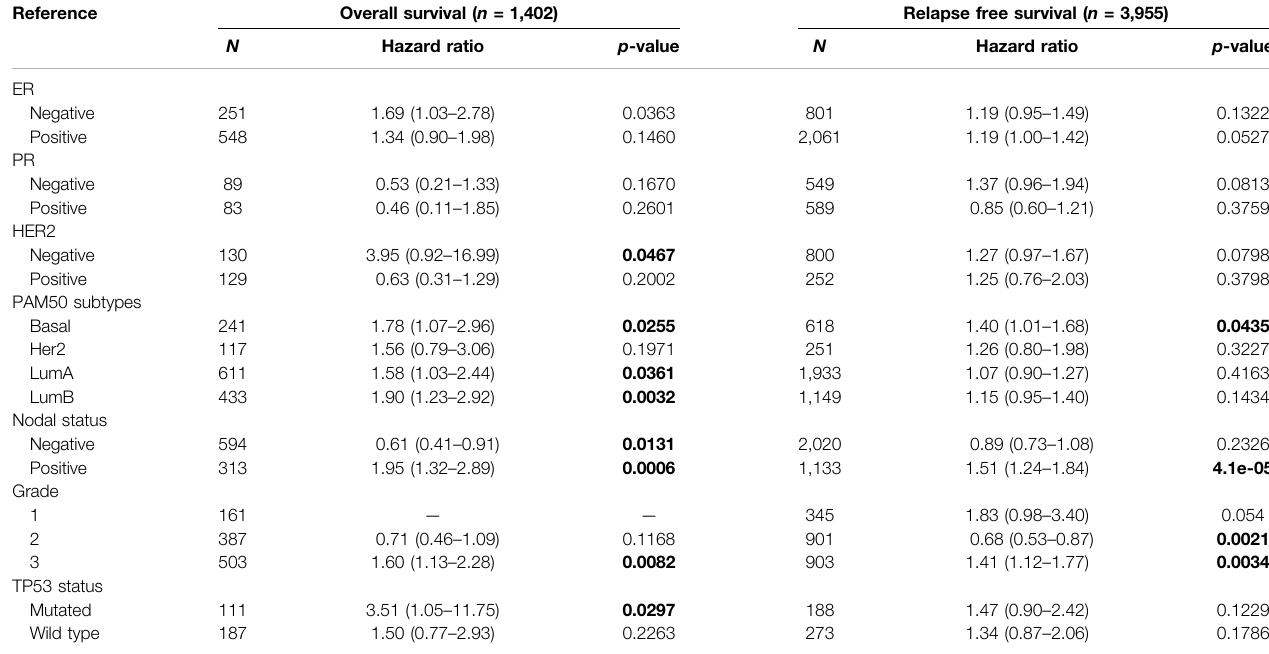
TABLE 2 | Correlation of INHBA mRNA expression and clinical prognosis in breast cancer with different clinicopathological factors by Kaplan – Meier plotter.